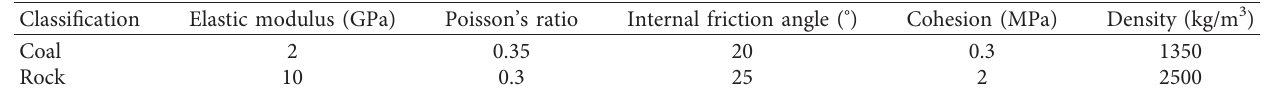
Figure 1: Example diagram of numerical simulation model of coal road driving with 0 ° and 20 ° dip angle coal Table 1: Mechanical parameters of coal and rock formations.